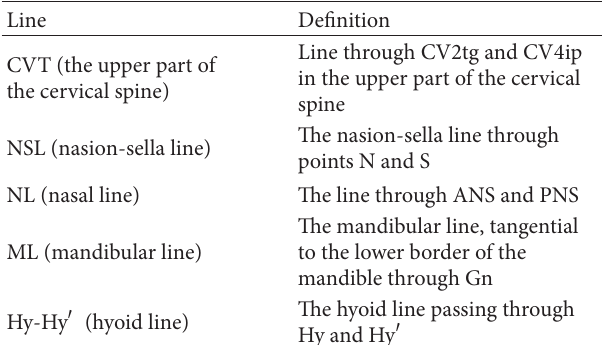
Table 2: Description of